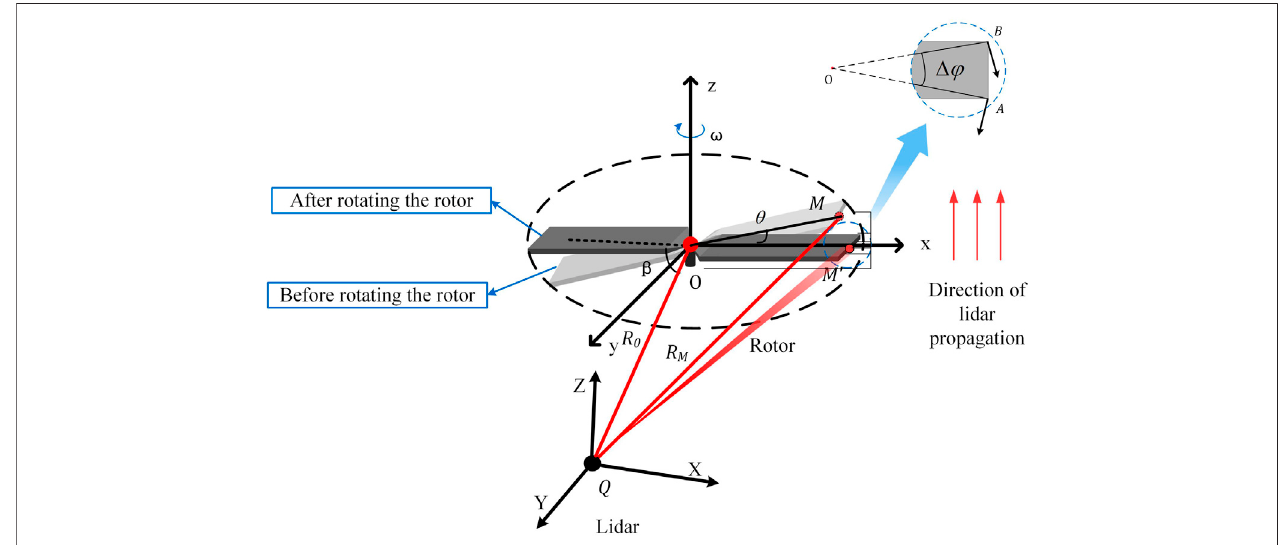
FIGURE 1 | Relative position of the rotor and laser line of